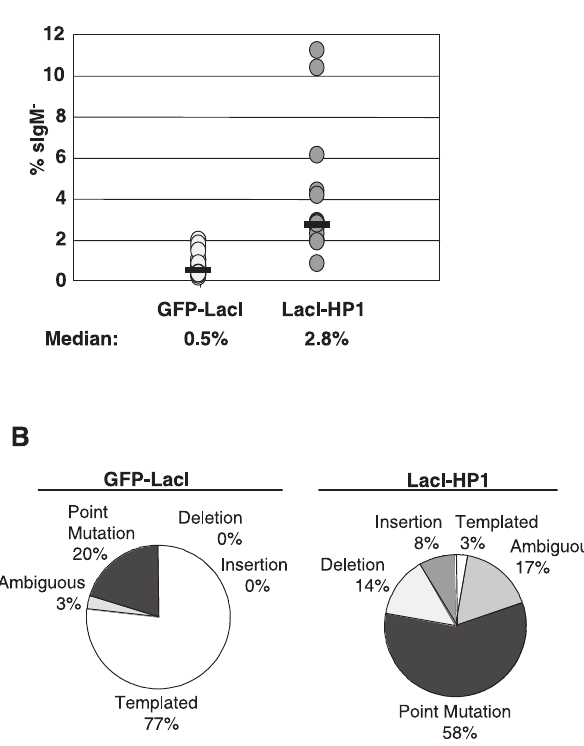
Figure 6. Nontemplated and Templated Mutation Promoted by Tethered HP1 (A) sIgM loss fluctuation assay of panels of independent DT40 PolyLacO- V k R GFP-LacI ( n ¼ 27) and DT40 PolyLacO-V k R LacI-HP1 ( n ¼ 16). The figure shows combined data from at least two independent transfectants for each fusion construct. Median diversification rates are shown below. (B) Summary of sequence analysis of V k regions carrying unique mutations from DT40 PolyLacO-V k R GFP-LacI ( n ¼ 71) and DT40 PolyLacO-V k R LacI-HP1 ( n ¼ 36) transfectants, as analyzed by single-cell PCR. Sequences were pooled from two independent